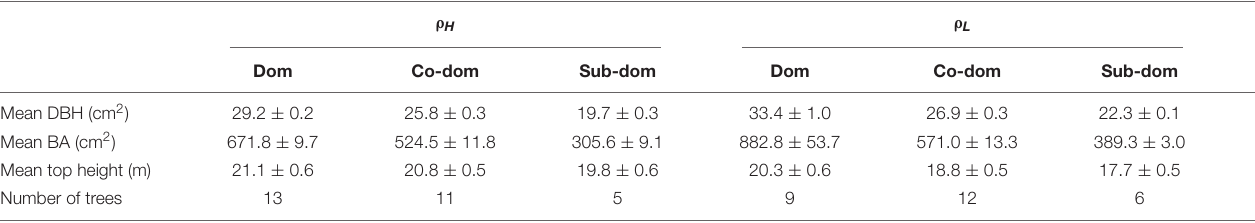
TABLE 1 | Stand characteristics at the time of sampling for felled Dominant (Dom), Co-dominant (Co-dom), and Sub-dominant (Sub-dom) P. sylvestris trees in both the high density ( ρ H ) and low density ( ρ L ) treatments.